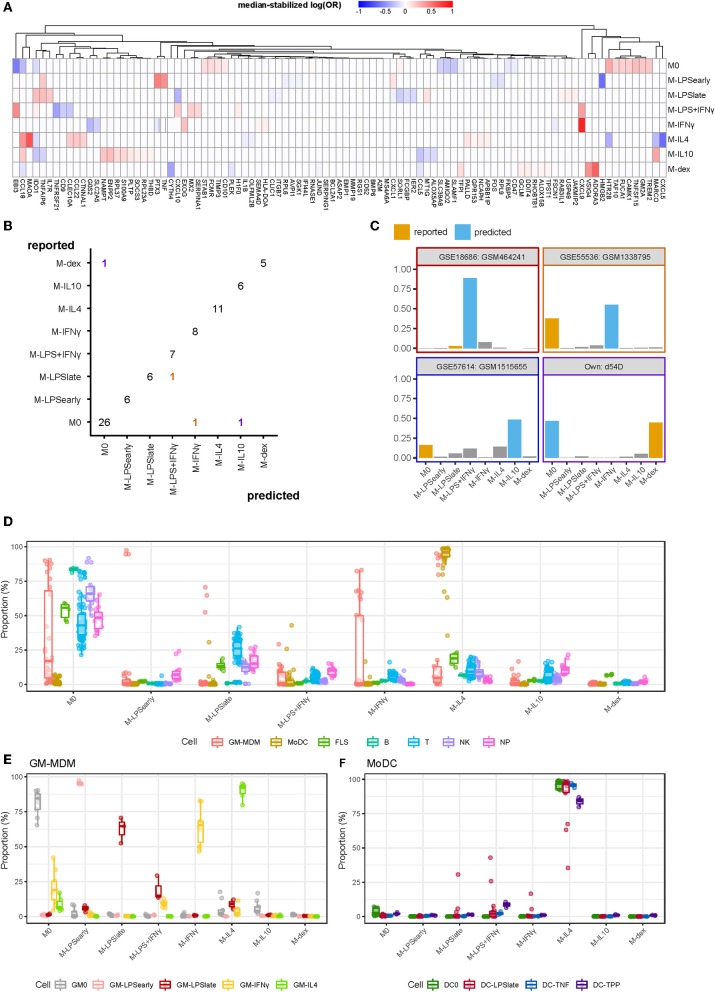
Summary classification analysis. (A) Heatmap of the median-stabilized log odds ratios per macrophage activation state for each of the 97 predictor genes. (B) Confusion matrix representing the number of correctly classified samples (entries on the diagonal) vs. the misclassified samples (entries on the off-diagonal). Classes on the y-axis represents the reported class while classes on the x-axis represent the predicted class. Colors represent the predicted classes with purple, red, yellow, and blue representing M-dex, M-LPS+IFNγ, M-IFNγ, and M-IL10, respectively. (C) Bar plots of the misclassified samples depicting the classification signal on a scale of 0 to 1 where the class with the largest signal represents the predicted class. Blue bars represent the incorrectly predicted class and orange bars represent the reported class. Border colors represent the predicted classes with purple, red, yellow, and blue representing M-dex, M-LPS+IFNγ, M-IFNγ, and M-IL10, respectively. (D) Boxplots representing the classification signal on a scale of 0 to 1 where classes with the largest signal represents the predictions. Colors represent GM-CSF differentiated macrophages (GM-MDMs), monocyte-derived dendritic cells (MoDCs), fibroblast-like synoviocytes (FLS), B lymphocytes (B), T lymphocytes (T), natural killer cells (NK), and neutrophils (NP). (E) GM-MDMs and (F) MoDCs colored by stimulation.